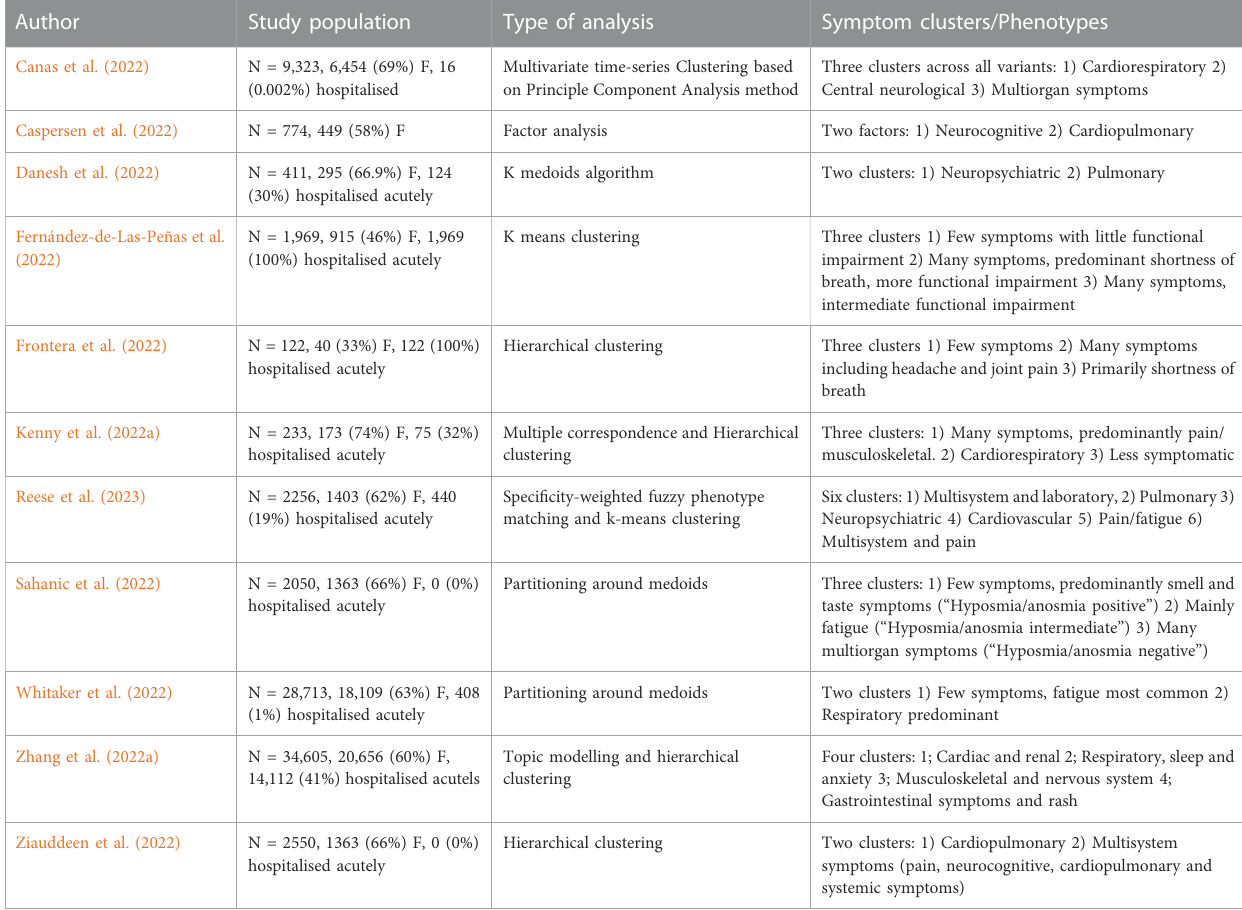
TABLE 1 Studies using unsupervised statistical methods to identify long COVID